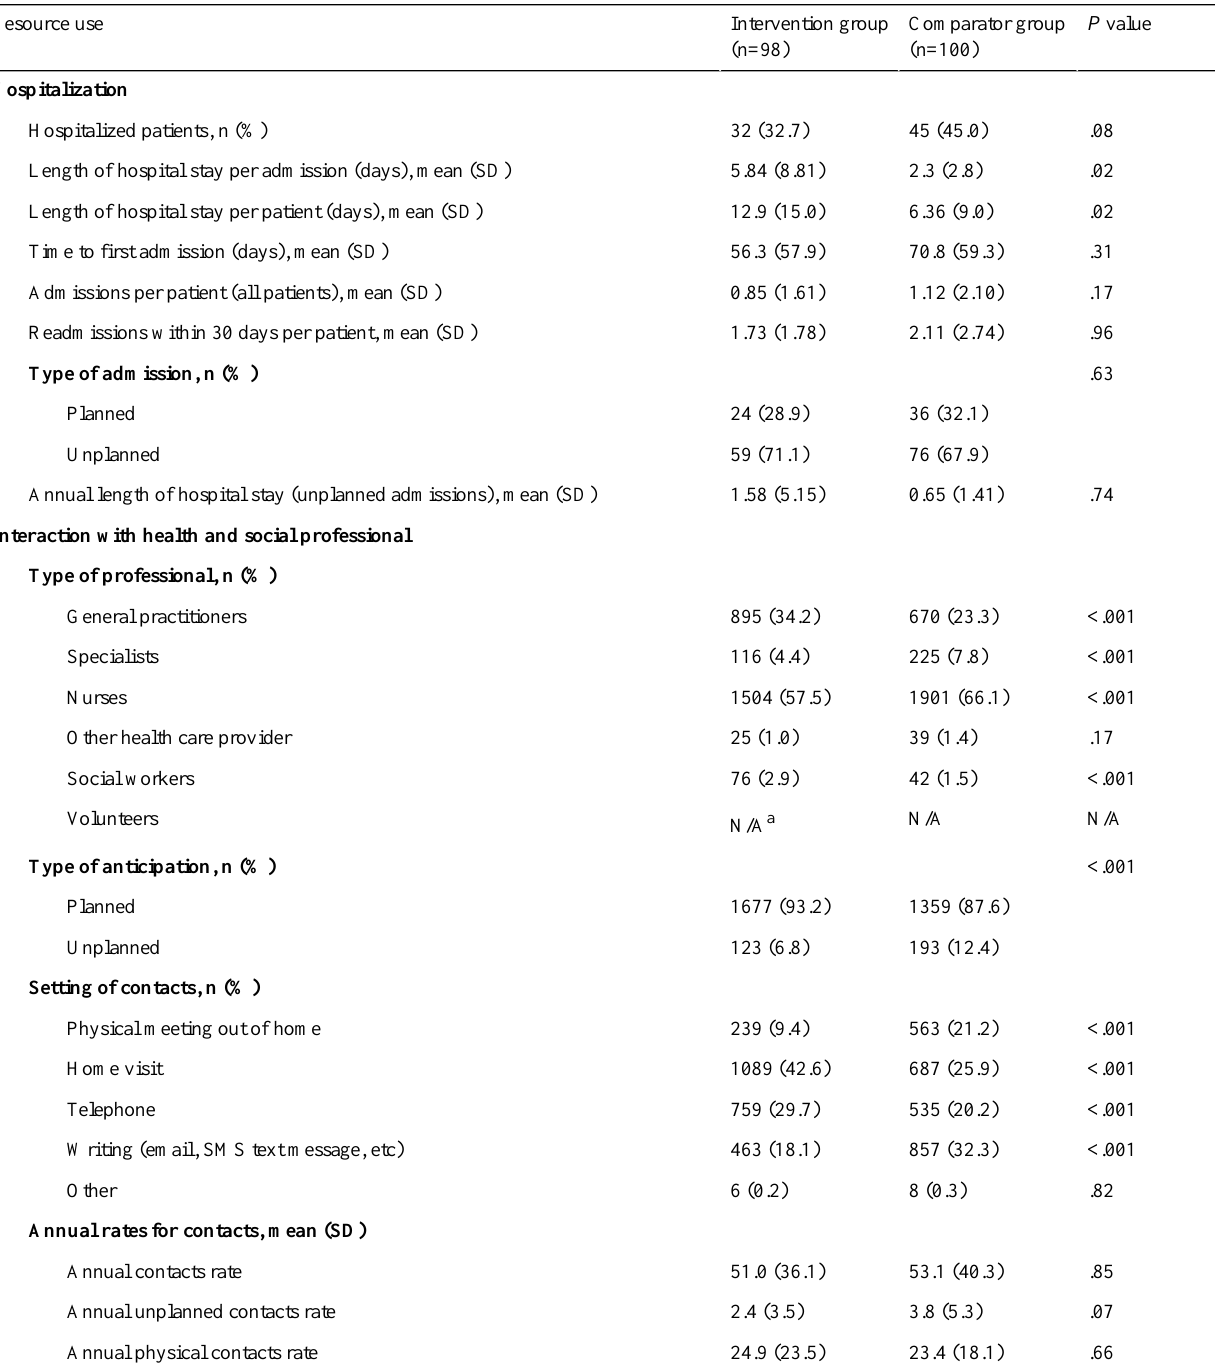
Table 3. Resource utilization of study participants